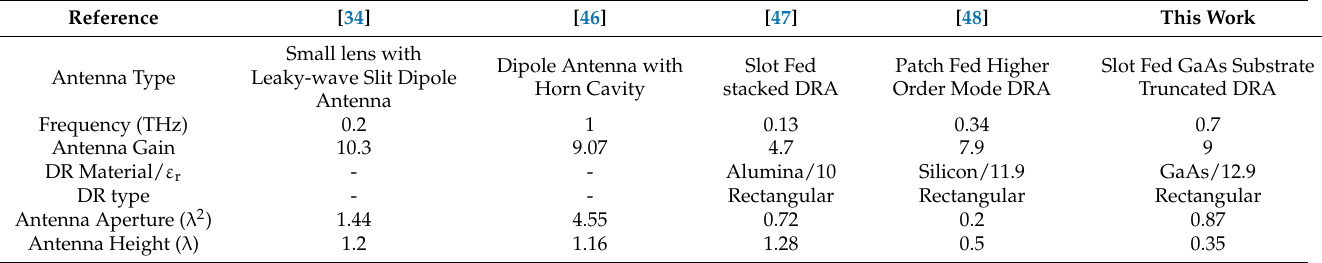
Table 1. Performance summary and comparison with prior